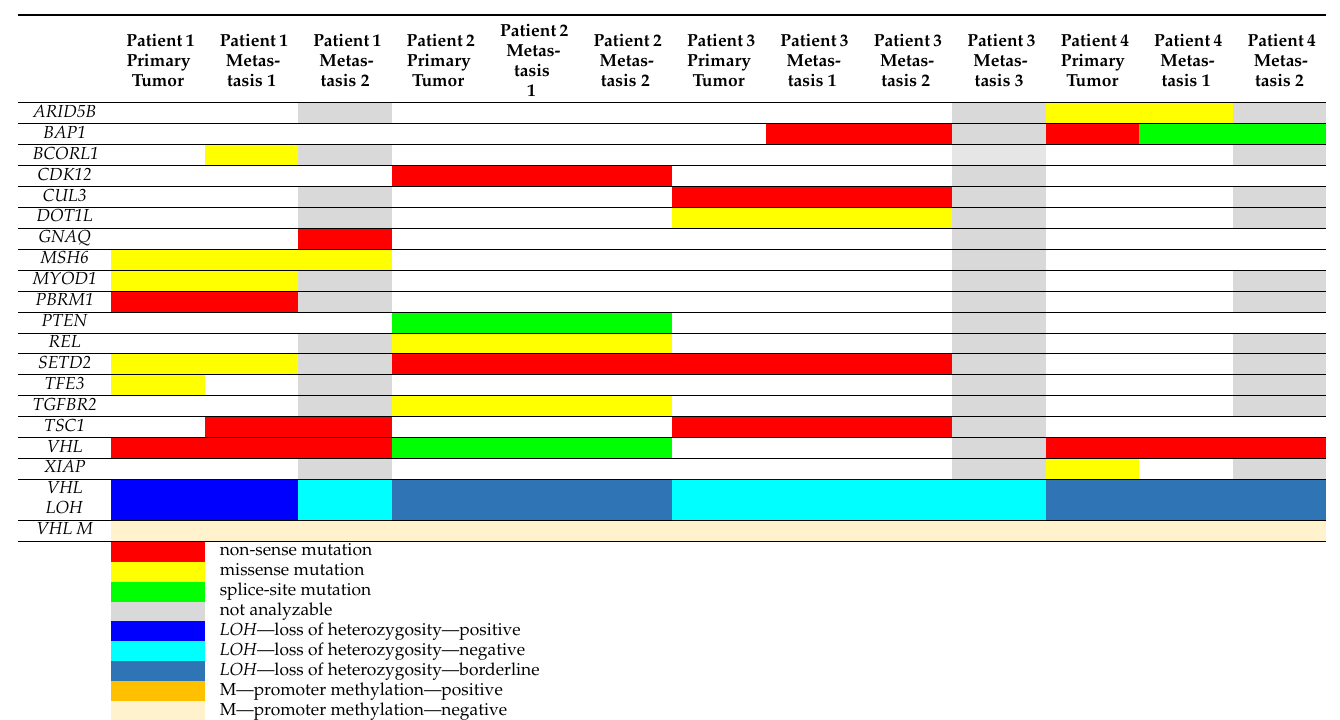
Table 5. The genetic profile of primary tumors and their